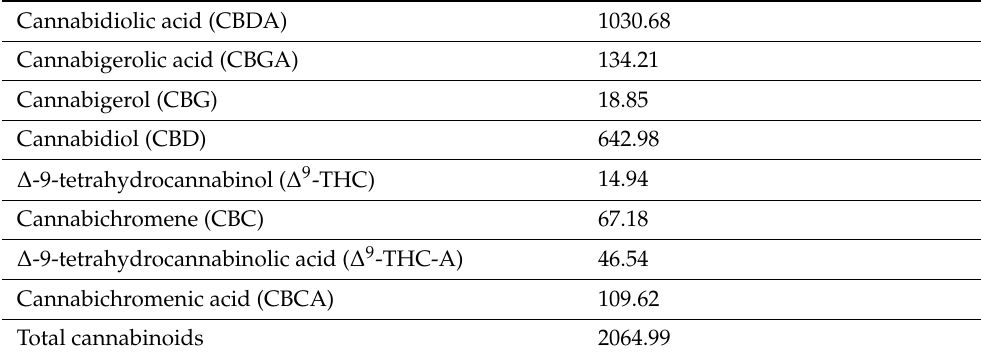
Table 2. Cannabinoids mass fraction [ µ g/g DW] in the hemp material used for the mealworm experiment.